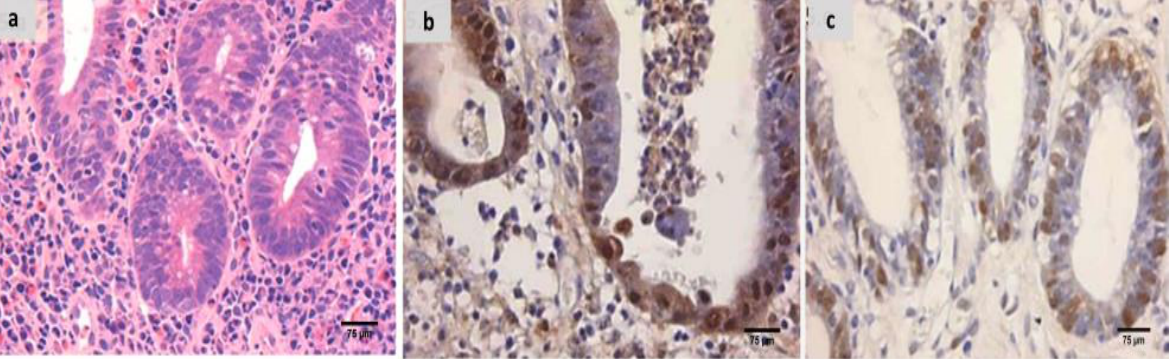
Figure 5. ( a ) Fidarestat treated group showing decreased activity into Geboes score of 3.2 in the form of cryptitis and neutrophils seen in most of the epithelium (H&E ×200). ( b ) The same case showed weak calprotectin but focal expression (x200), ( c ) also showed weak and focal S100A12 expression ( ×200).